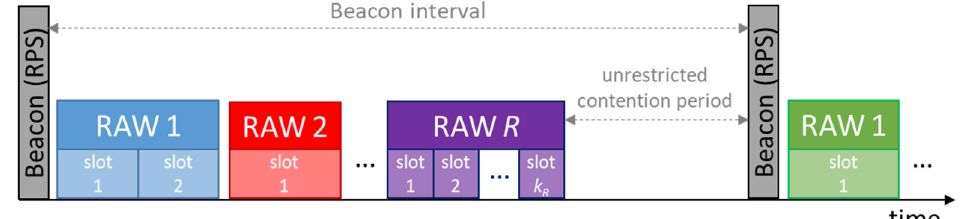
Figure 1. Example of a distribution of the airtime between consecutive Beacons using IEEE 802.11ah’s RAW.